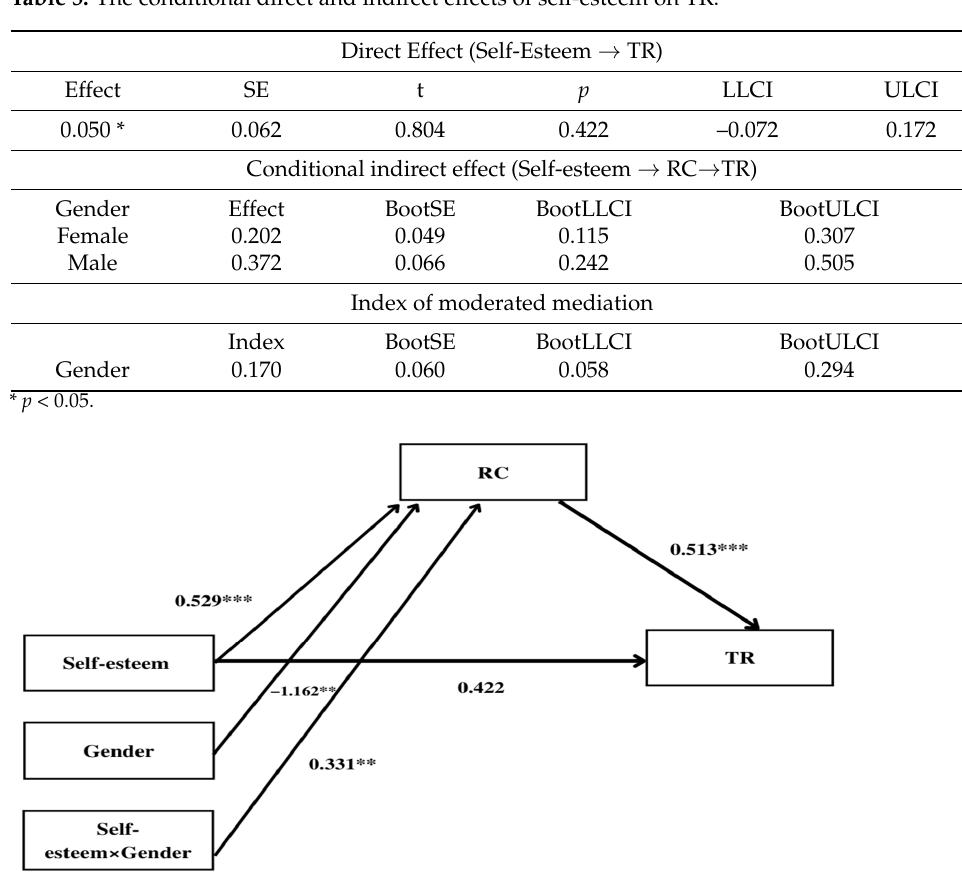
Figure 2. Statistical Figure on Moderated Mediation Effects of Gender. ** p < 0.01, *** p < 0.001.